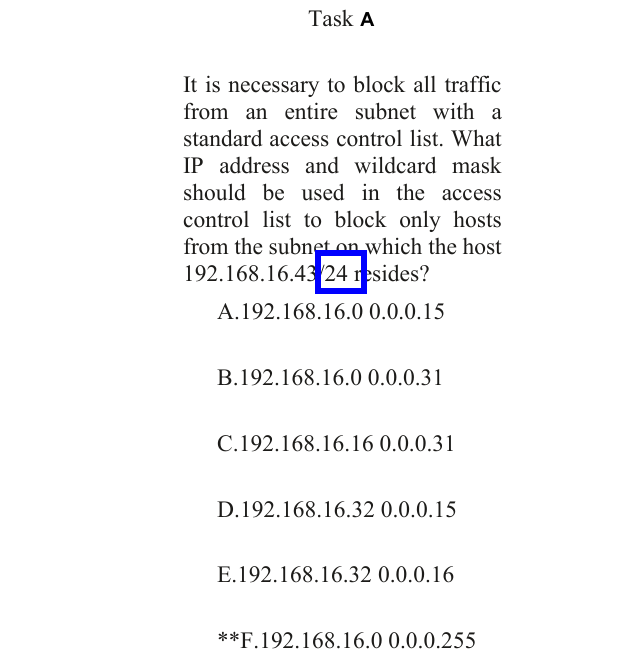
FIGURE6 An example of a task taken from West et al. (2012).